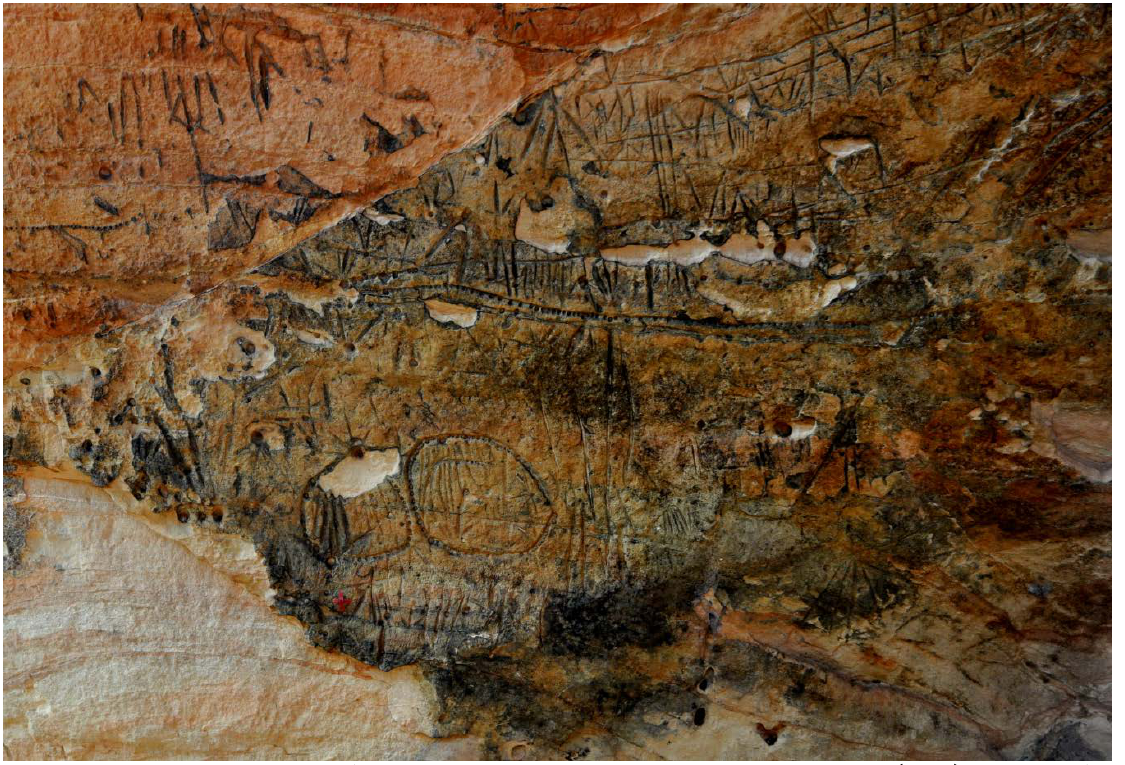
Figura 2: Gravuras rupestres do Sítio Abrigo do Alvo conforme descrito por Alberto (2013). Foto de Sílvia Cunha Lima (2012). Figure 2. Rock engravings from Abrigo do Alvo, according to descriptions by Alberto (2013). Photo by Silvia Cunha Lima